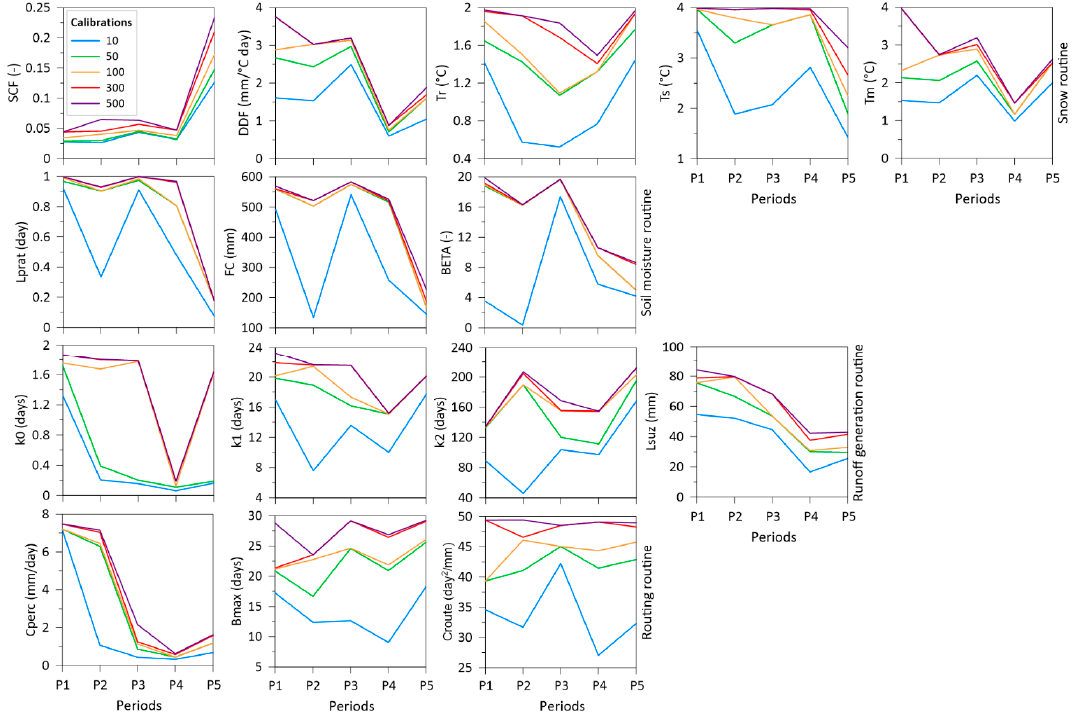
Figure 7. Ranges of model parameters after 10, 50, 100, 300, 500 calibration repetitions in five specific periods.